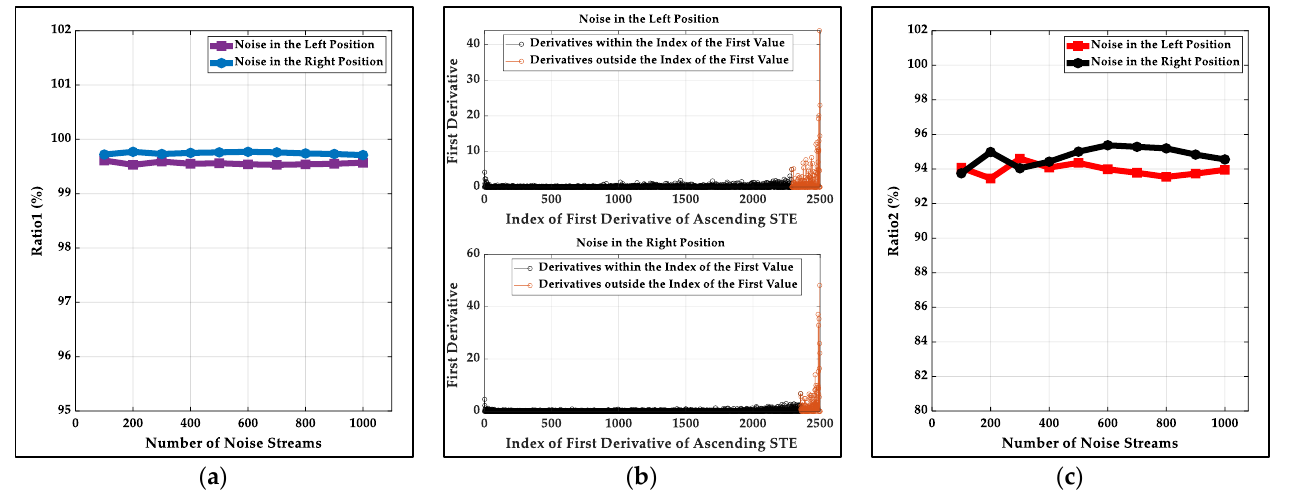
Figure 7. The characteristic of the first derivatives of environmental noise’s ascending STE: ( a ) the statistical ratio (named Ratio1) of the first derivatives less than or equal to the maximum first derivative of the first half U-shape to all first derivatives; ( b ) the distribution of first derivatives whose indexes are from 1 to the index of the first value; ( c ) the statistical ratio (named Ratio2) of the first derivatives whose indexes are from 1 to the index of the first value to all first derivatives.